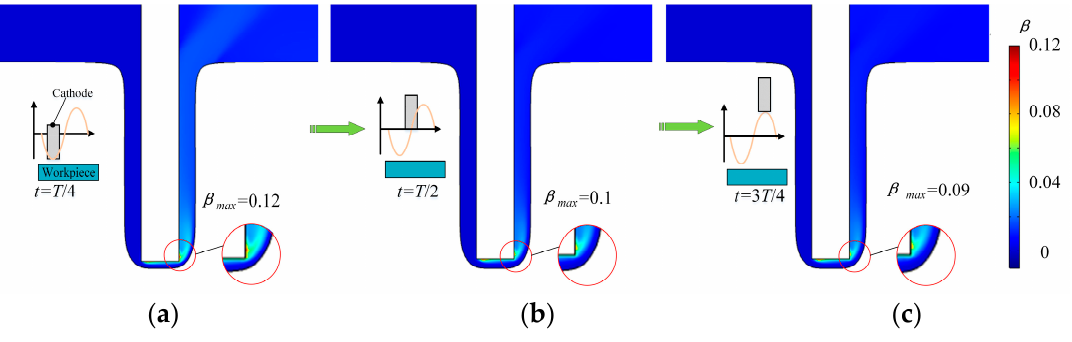
Figure 9. Distributions of gas-phase volume fraction over time; ( a ) t = T /4. The maximum volume fraction of hydrogen bubble is 0.12 at the cathode’s nearest position to anode; ( b ) t = T /2. The maximum volume fraction of the hydrogen bubble is 0.1 at the middle position; ( c ) t = 3 T /4. The maximum volume fraction of the hydrogen bubble is 0.1 at the cathode’s farthest position.